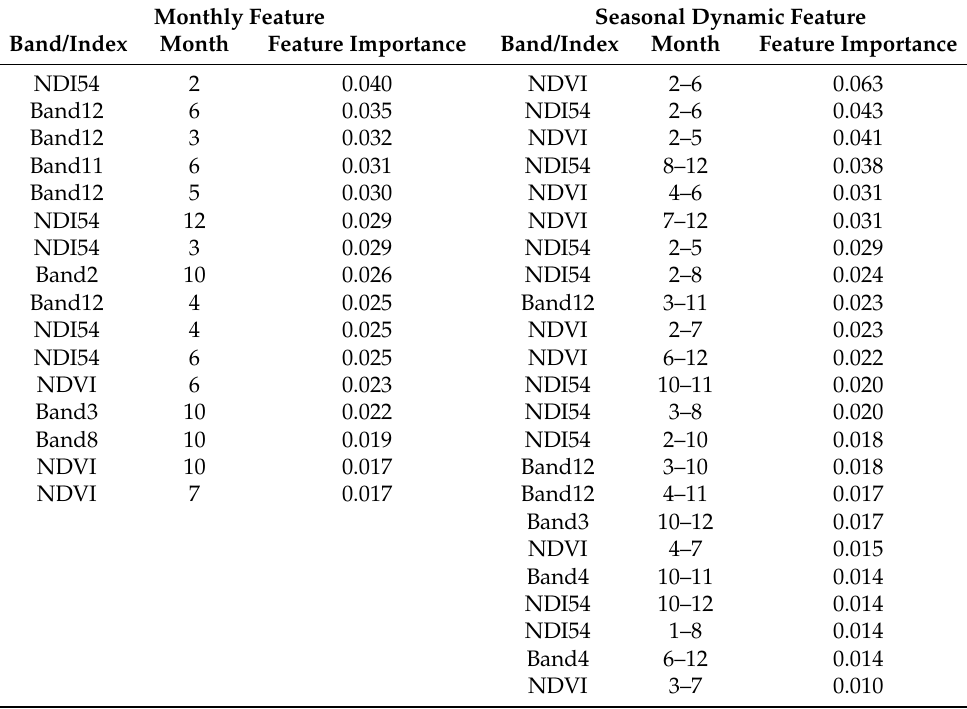
Figure 4. Relationship between mean accuracy and number of features fed to the MLP classifier. The flat horizontal dashed line represents the accuracy from a model using all features. Table 1. Feature information of the 40 features finally retained to feed the MLP model including monthly features (band/spectral index and specific month) and seasonal dynamics features (band/spectral index and related months).